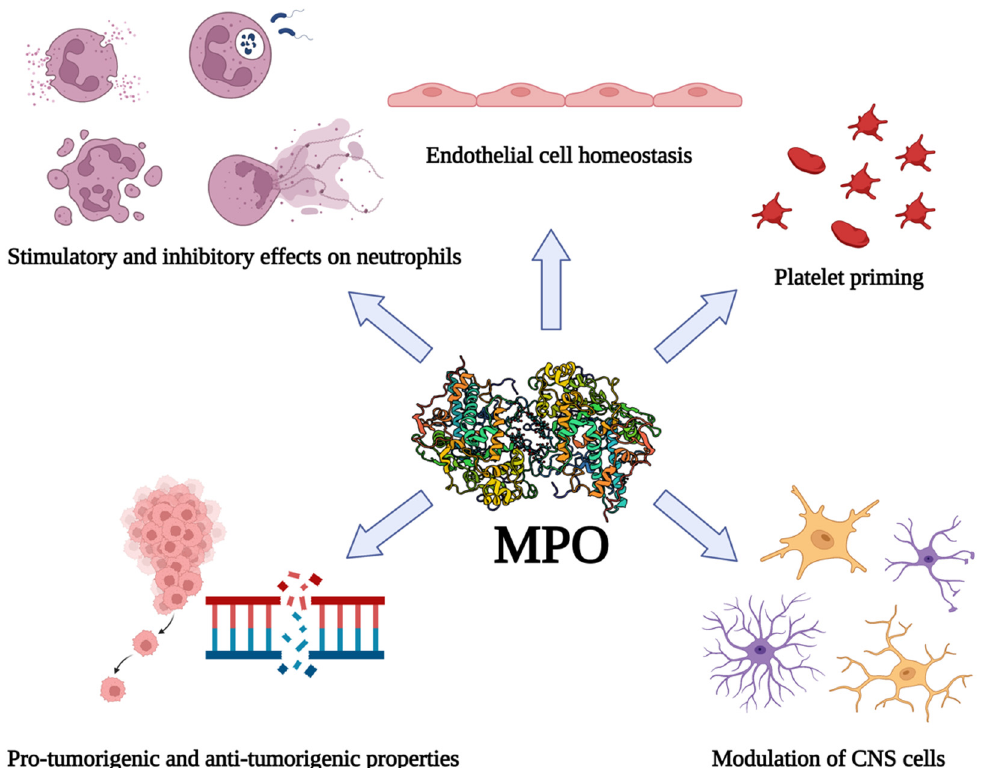
Figure 1. Non-canonical functions of MPO in tissue inflammation. In addition to its canonical antimicrobial activity, MPO can impact many other calls and biological processes in inflammation. Figure generated with Biorender (Publication License #BL24B6KVKU).